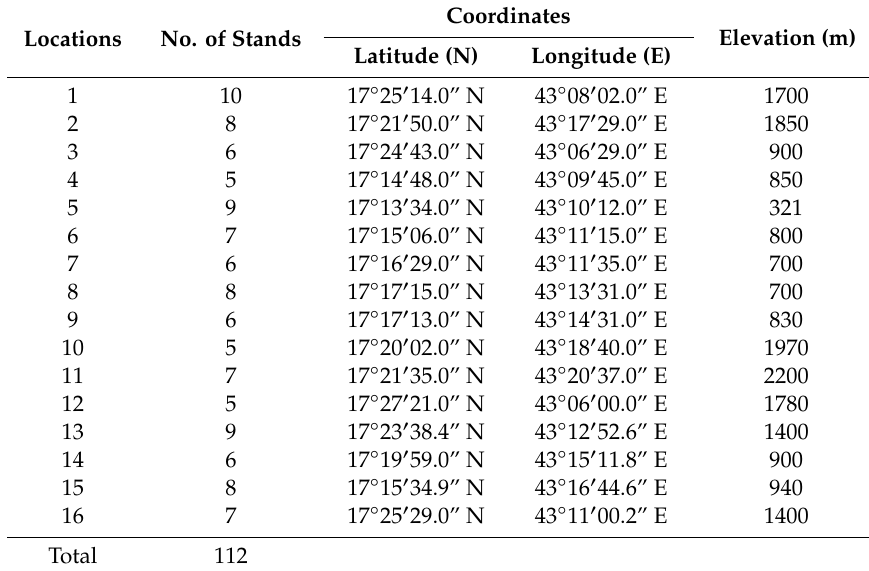
Table 1. Locations of the studied areas in Jabal Fayfa showing the sampling sites with their coordinates, number of stands, and